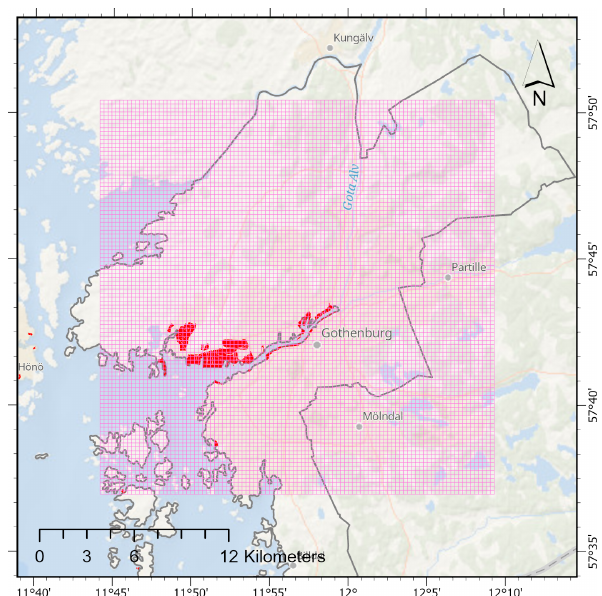
Figure 1. The Gothenburg research domain. The light red grid indi- cates the domain extent and the horizontal grid-cell size of 250m. Red areas indicate port areas and grey lines indicates the city bound- aries as given by the Copernicus Urban Atlas 2012 dataset. Maps are created with ArcGIS with the underlying basemap sources Esri, HERE, Garmin, GEBCO, National Geographic, NOAA, and GIS User Community.